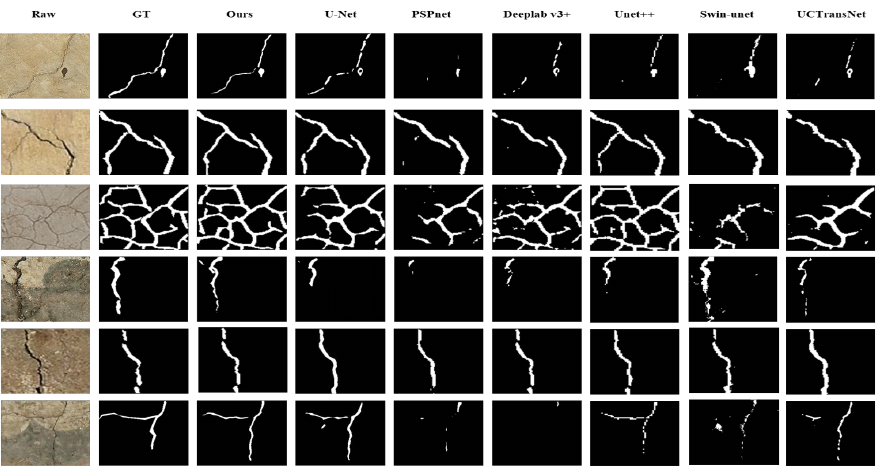
Figure 8. Comparison of the results of different methods for six selected images from the test set.